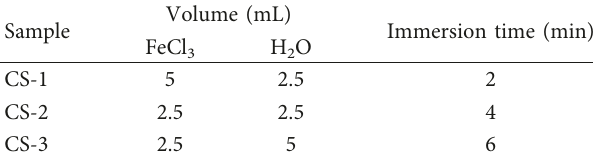
Table 1: Parameters for selective corrosion in Cu